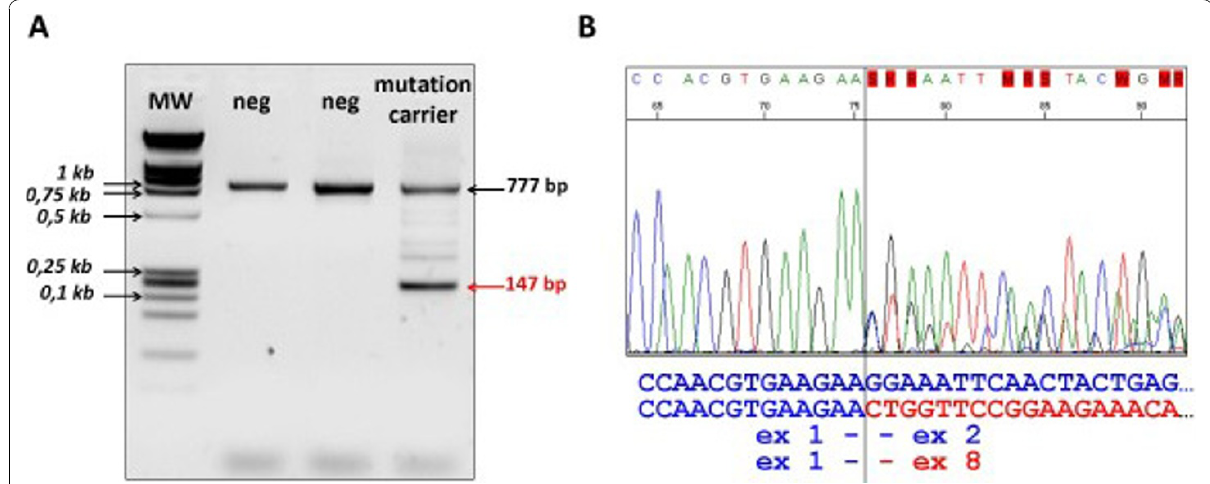
Figure 3 PCR analysis and sequencing results of the proband of family HP10 presenting with a large genomic deletion encompassing exons 3-7 . Panel A shows the results of the PCR amplification of the cDNA sample of the mutation carrier along with samples from two negative controls (designated as ‘ neg ’ ), using a sense primer in exon 1 and an antisense primer in exon 8. The extra band in the mutation carrier sample (marked by a red arrow) indicates the presence of a variant mRNA species resulting from fusion of exon 1 to exon 8. Faint bands on the gel are most likely the results of heteroduplex molecules. MW: molecular weight marker; neg: mutation negative samples. The sequencing result illustrating the skipping of exons 2-7 is shown on Panel B with the sequences of the normal as well as the mutant allele given below the